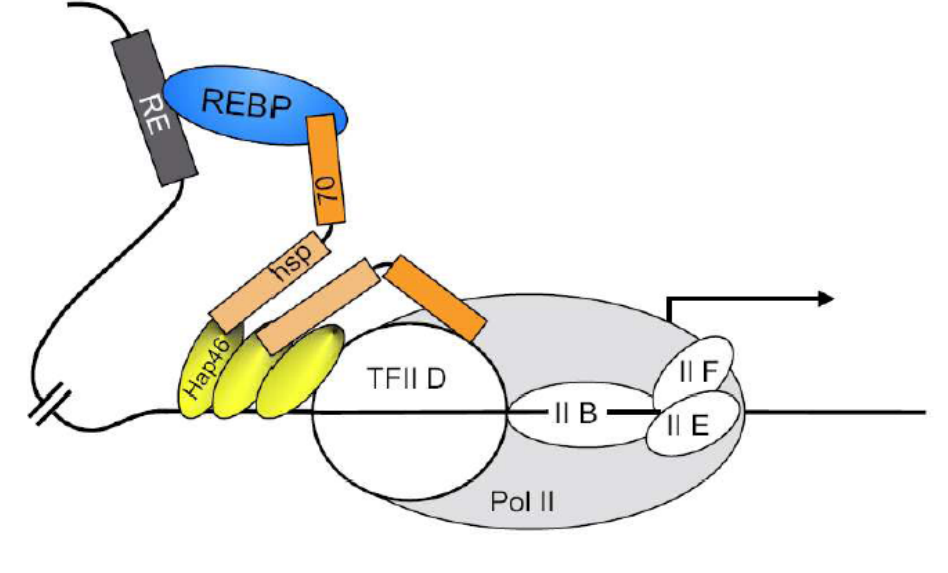
Figure 6. Molecular model for the effects of Hap46/BAG-1M on transcription. The transcription initiation complex is shown in a simplified version. Arbitrarily, three molecules of Hap46/BAG-1M are depicted in association with DNA and are supposed to establish contacts via hsp70 molecular chaperones. Pol II: RNA polymerase II; TFII: basal transcription factor II; RE: response element on DNA; REBP: specific response element- binding protein, for example a liganded and activated steroid hormone receptor. From